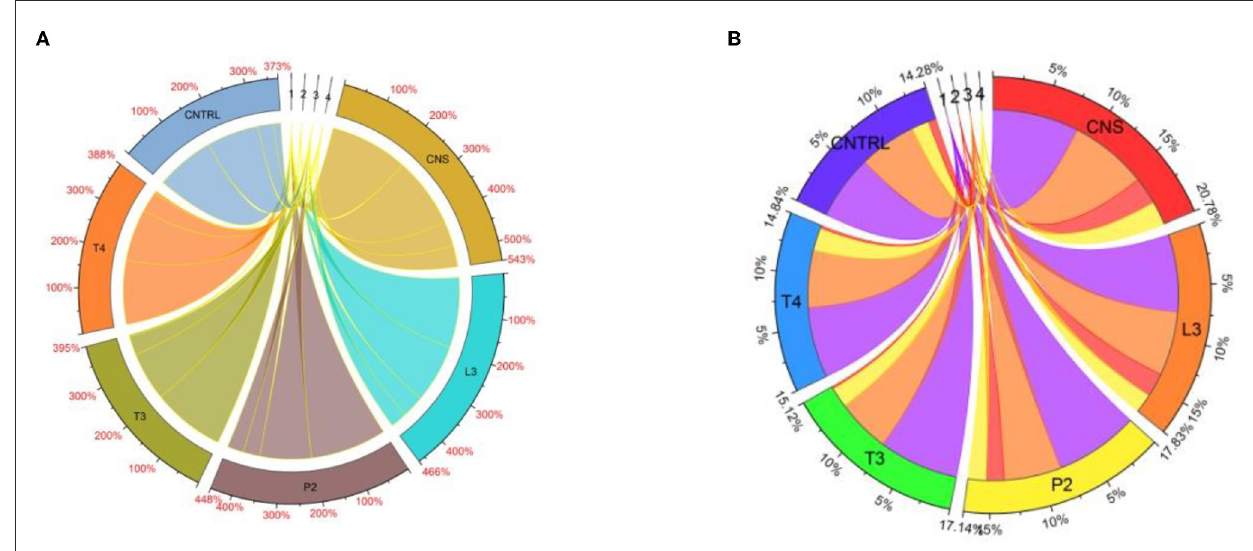
FIGURE10 Chord analysis of chlorophyll showing response percent sharing of PSB treatments in the field set 1 (A) and field set 2 (B) .